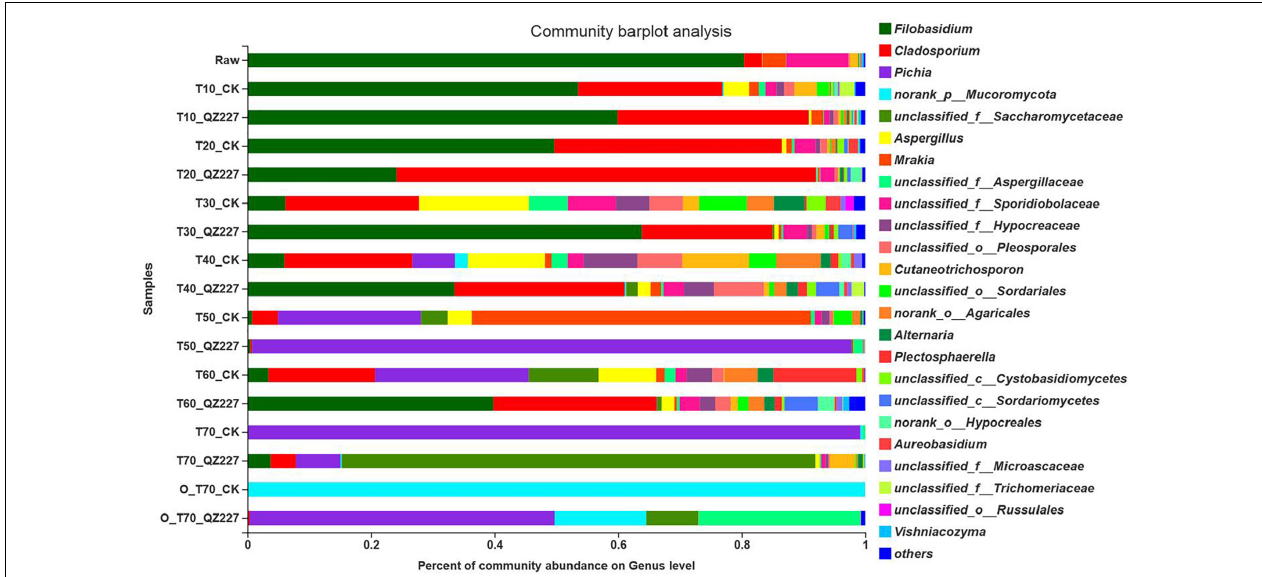
FIGURE 6 | Fungal community barplot analysis at the genus level. The y – axis is the name of the sample, the x – axis is the proportion of the species, Colored columns indicate different genera, and the length of the columns represents the proportion of the genera.